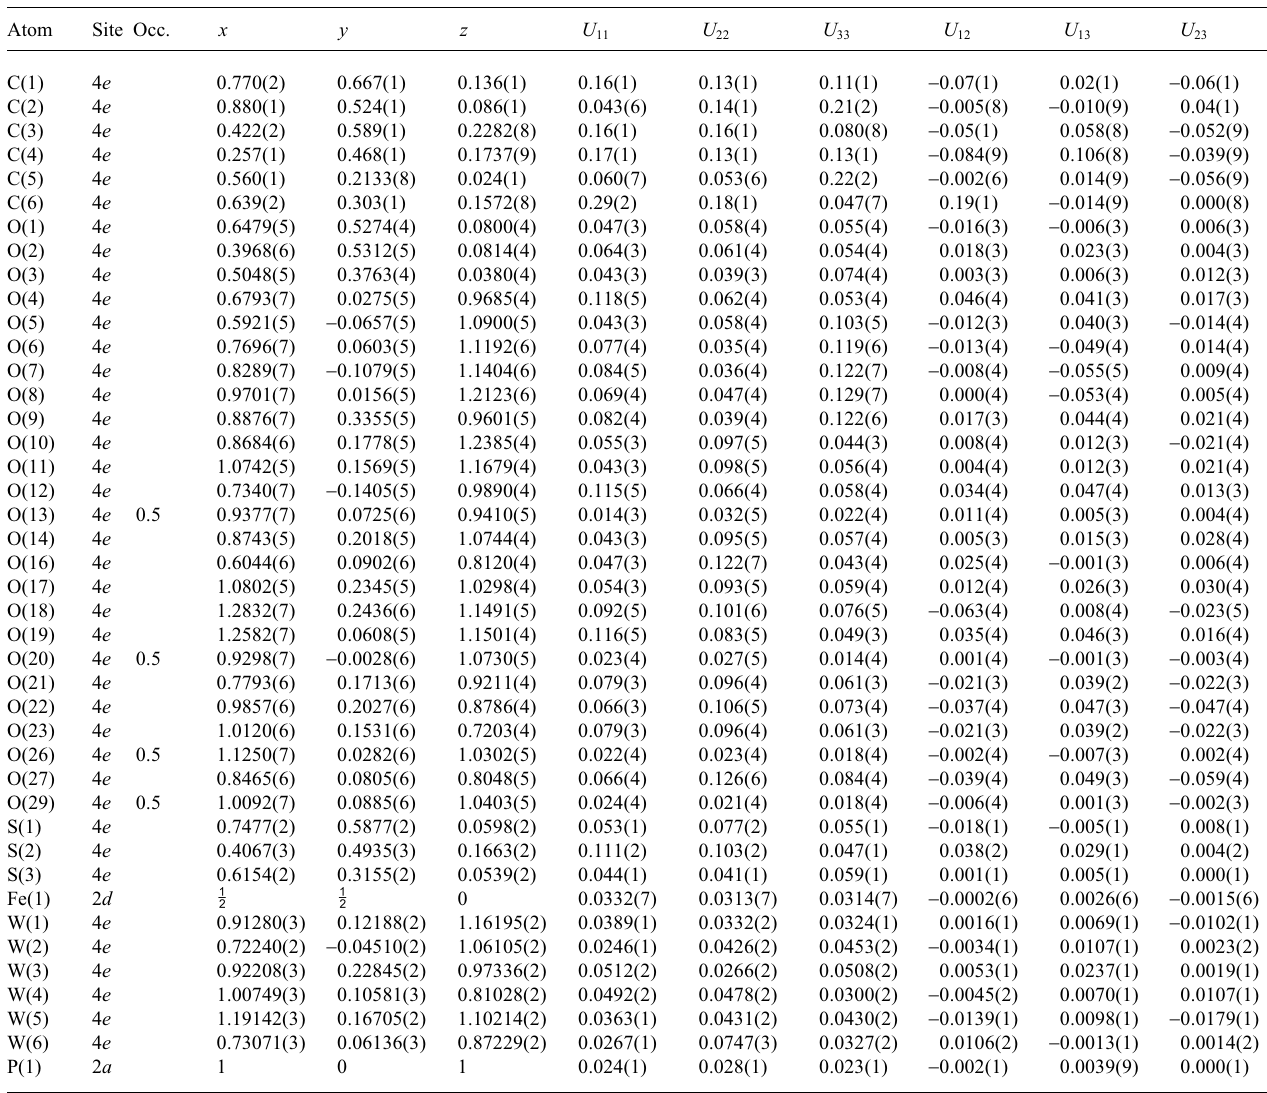
Table 3. Atomic coordinates and displacement parameters (in Å 2 ) . Atom Site